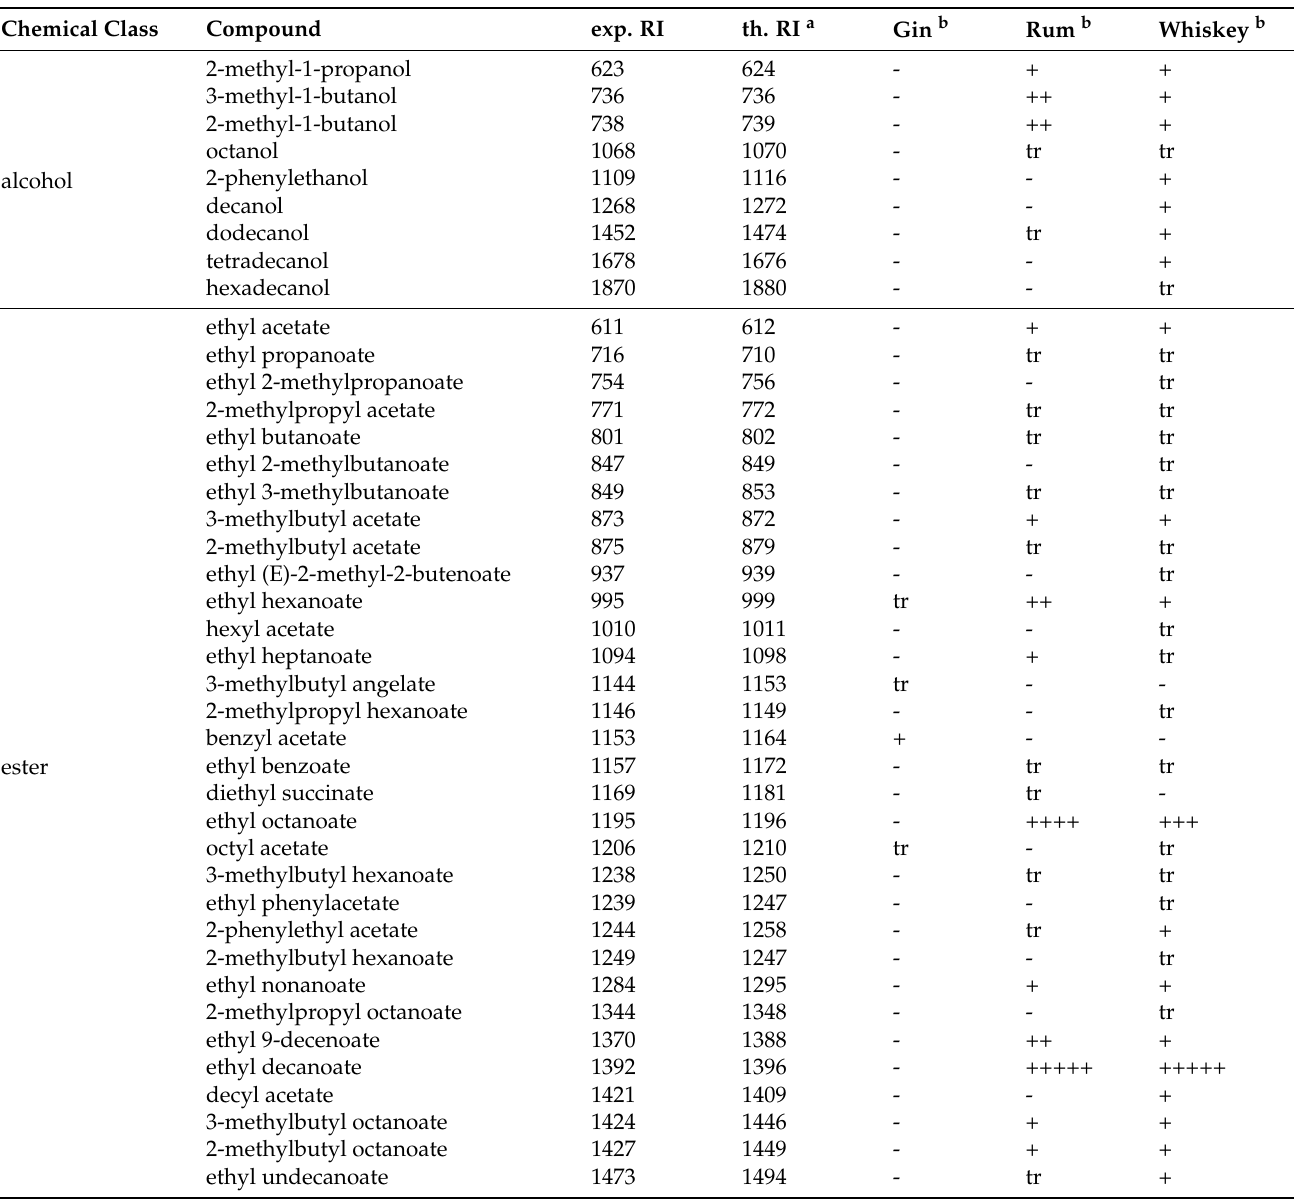
Table 4. Volatile compounds by chemical class identified in 3 commercial liquors analyzed by